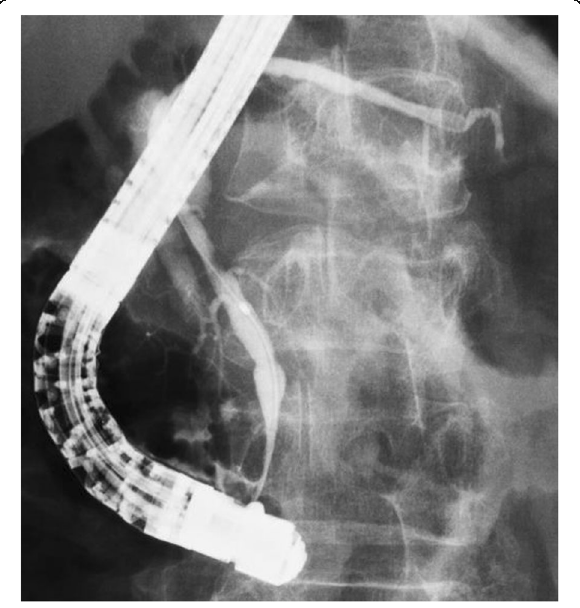
Fig. 5 Endoscopic retrograde cholangiopancreatography showed no dilation of the main pancreatic duct and its branch. No mucinous production was detected during any of the